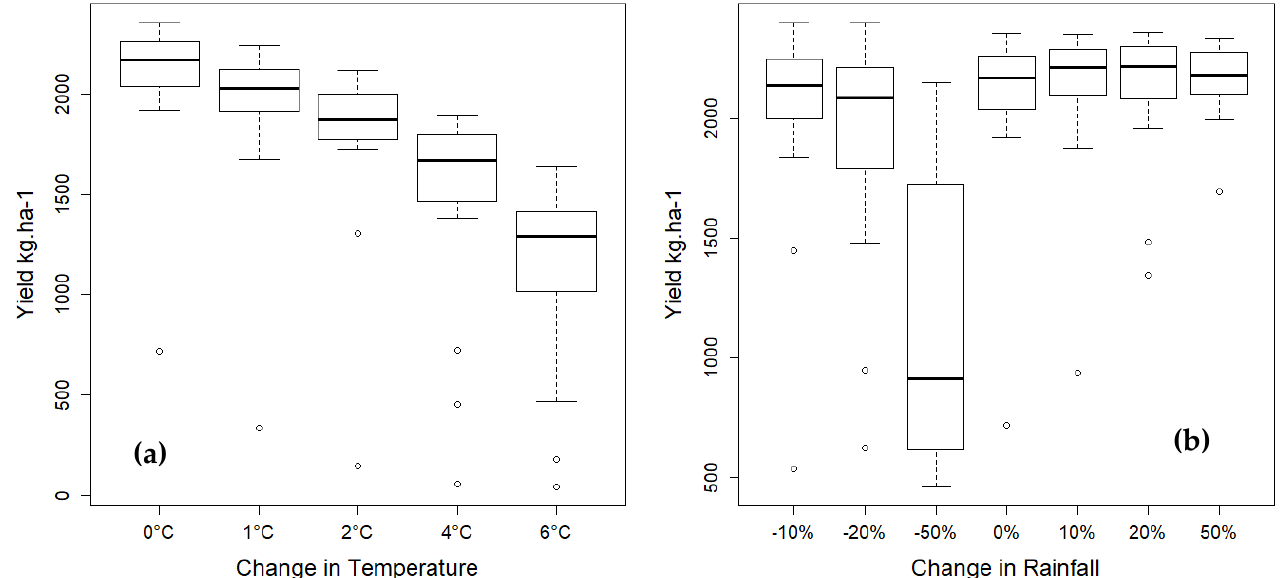
Figure 4. Simulated yield response to rainfall and temperature changes for sensitivity analysis: ( a ) change in temperature; ( b ) change in rainfall .